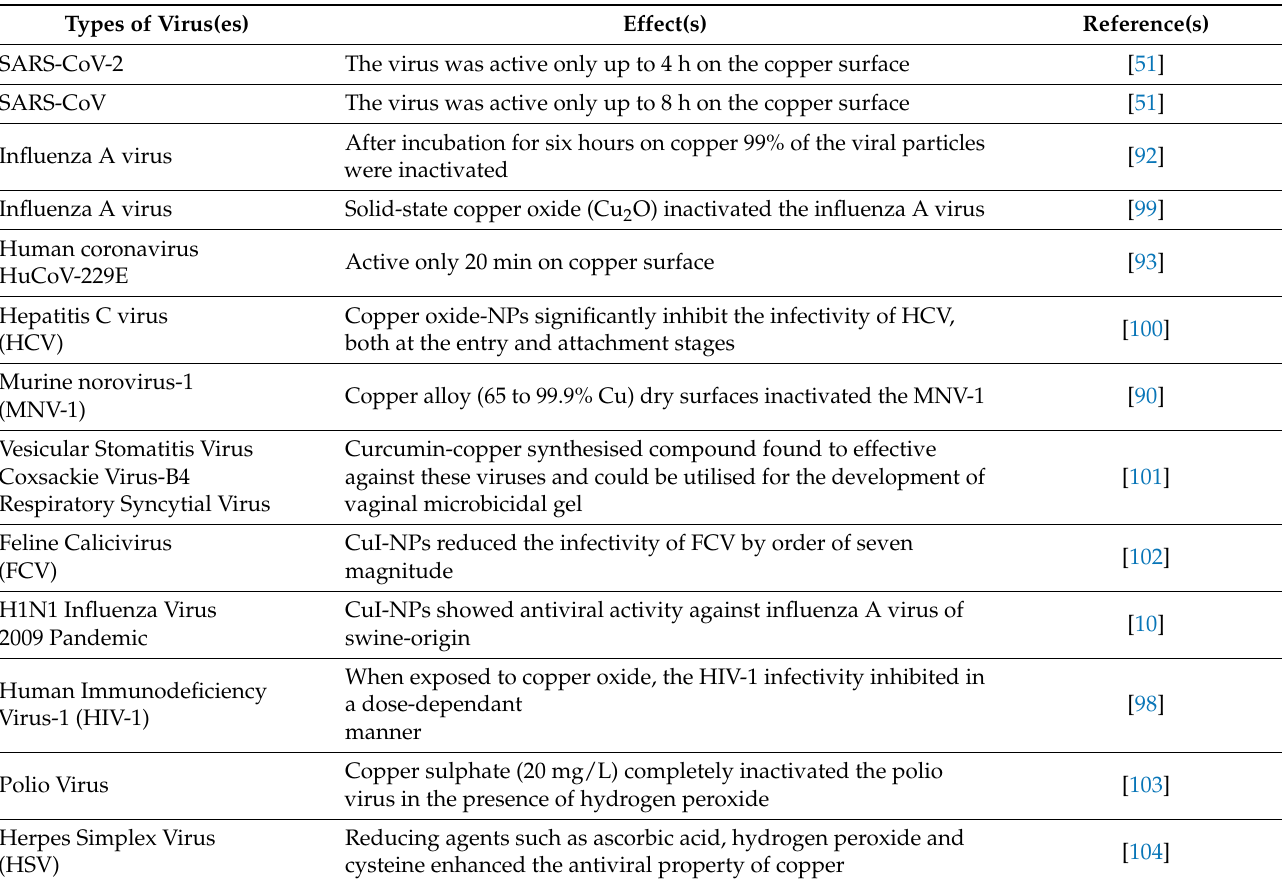
Table 2. Biocidal activity of copper on various